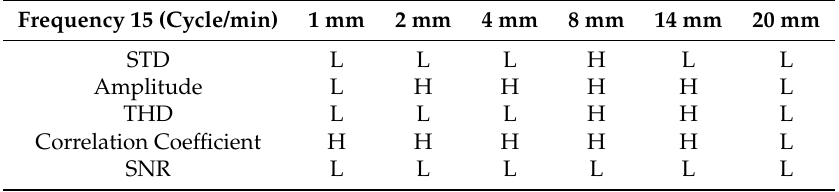
Table A3. Values higher and lower than the median Frequency 15 cycles/min for a 2 mm band.